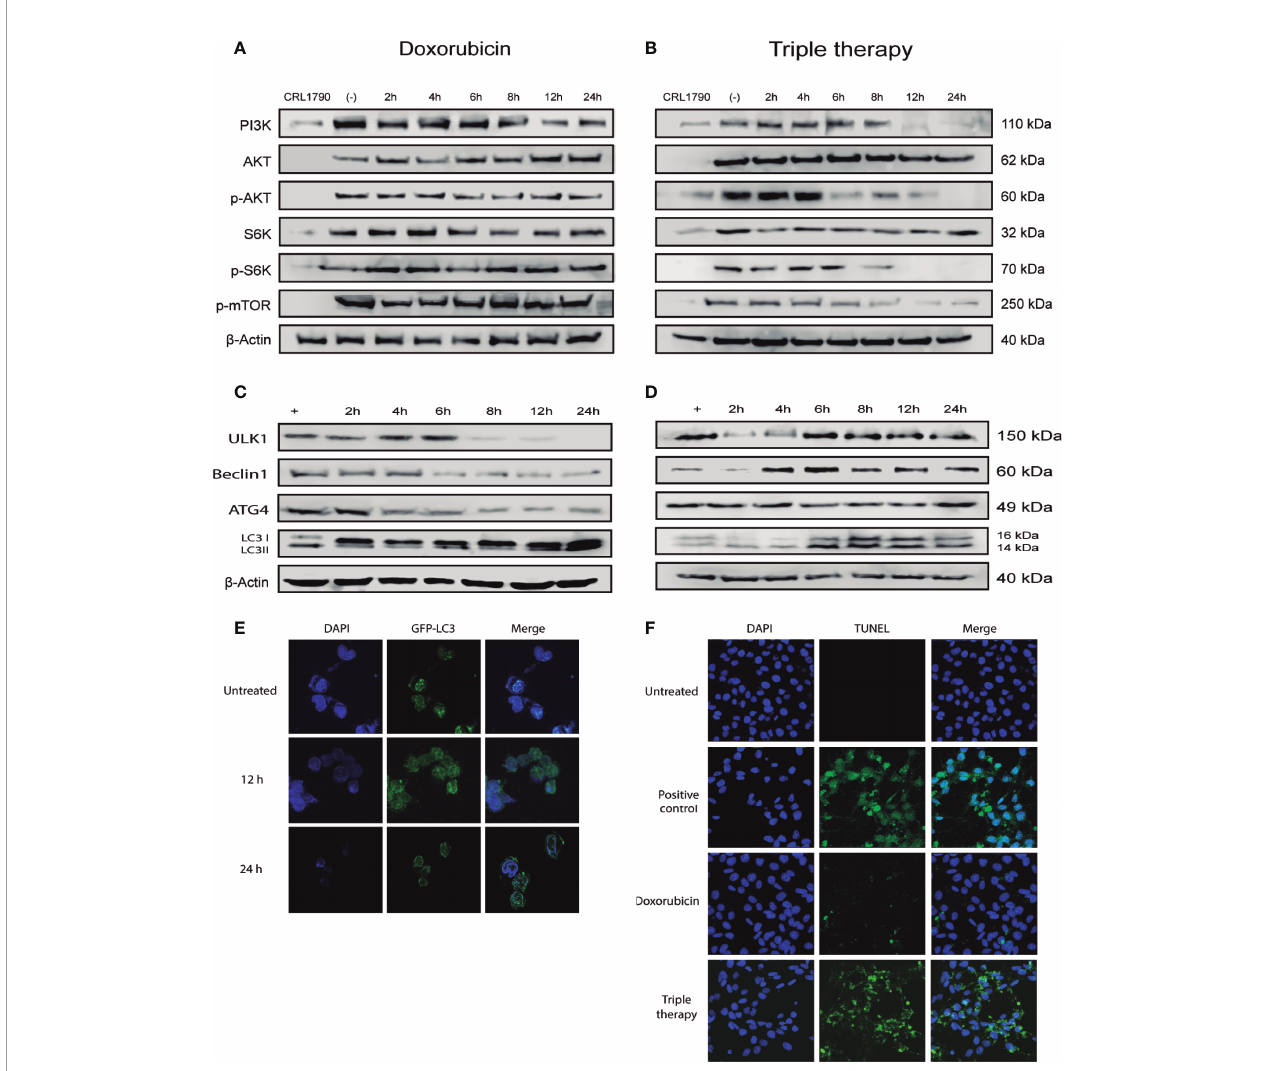
FIGURE 2 | Tt induces cell death by autophagy in HCT116 cells. (A, B) Detection of PI3K/AKT pathway components in HCT116 cells treated with Doxorubicin and Tt, b -actin was used as loading control. (C, D) Protein levels of key autophagy components in HCT116 cells treated with Doxorubicin and Tt. (E) Confocal microscopy of HCT116 transfected with LC3-GFP under Tt treatment for 8 and 12 h. (F) Tunel assay of HCT116 under Dox and Tt